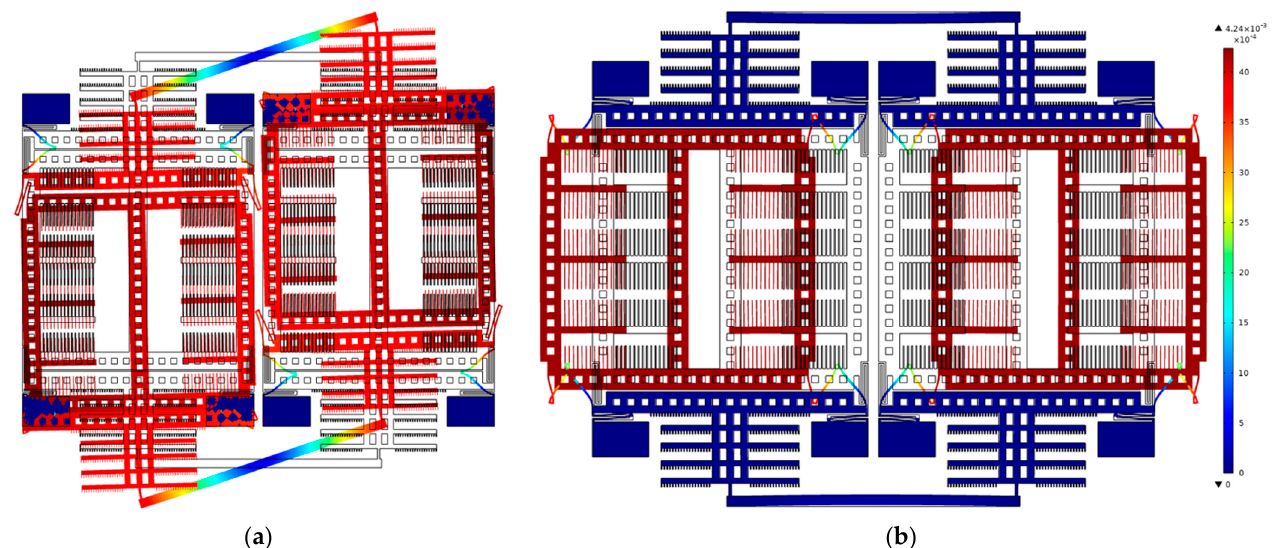
Figure 2. The simulated results of dual − mass TFGs with symmetrically decoupled lever structures: ( a ) the antiparallel, antiphase drive − mode motion, and ( b ) the linearly coupled antiphase sense − mode motion.